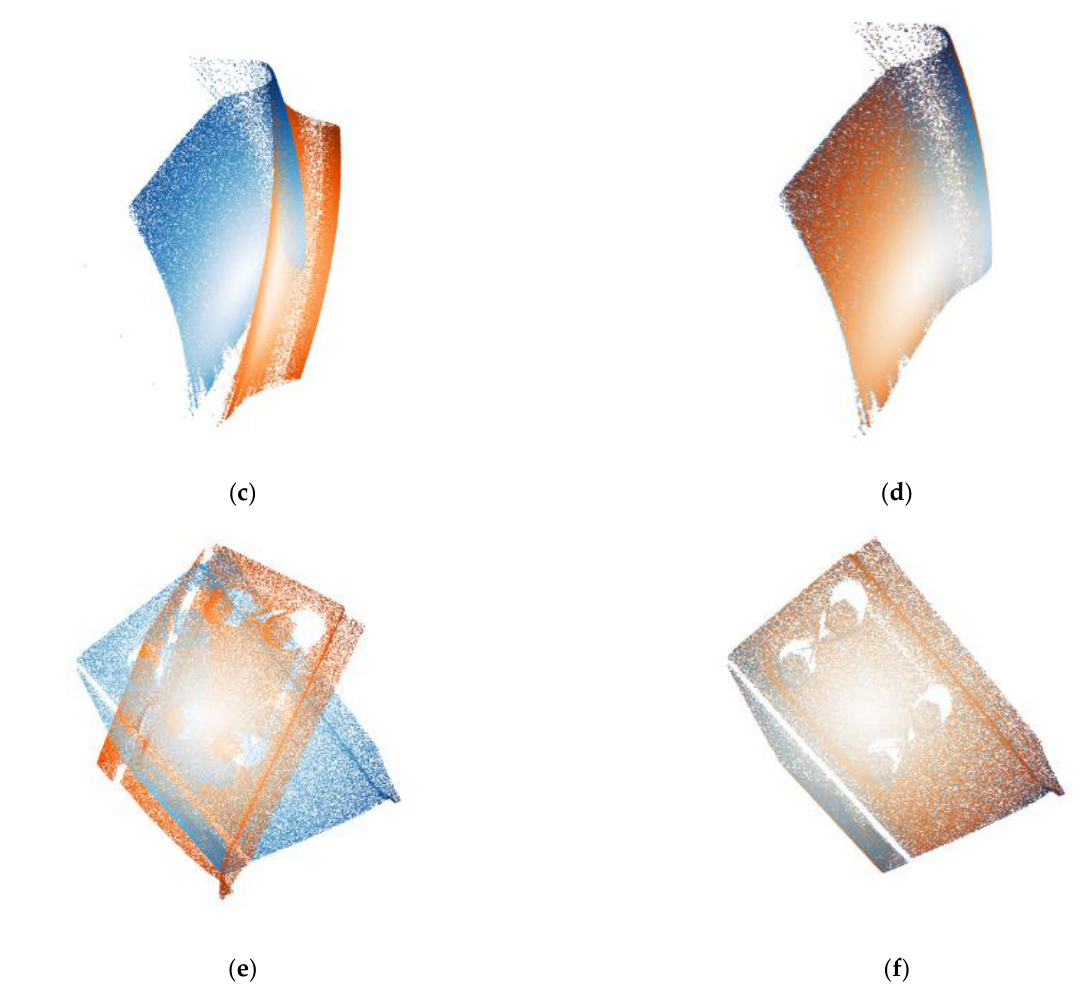
Figure 6. Registration results of real data. ( a , c , e ) are the initial position of the two point clouds, ( b , d , f ) are the results of registration, the yellow point set is the source point cloud and the blue point set is the template point cloud.